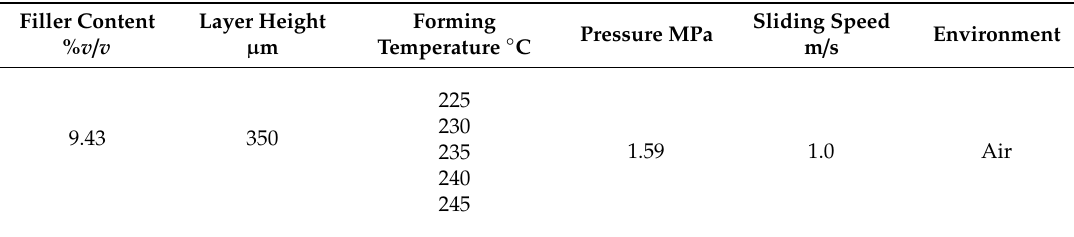
Table 3. Experiment parameters